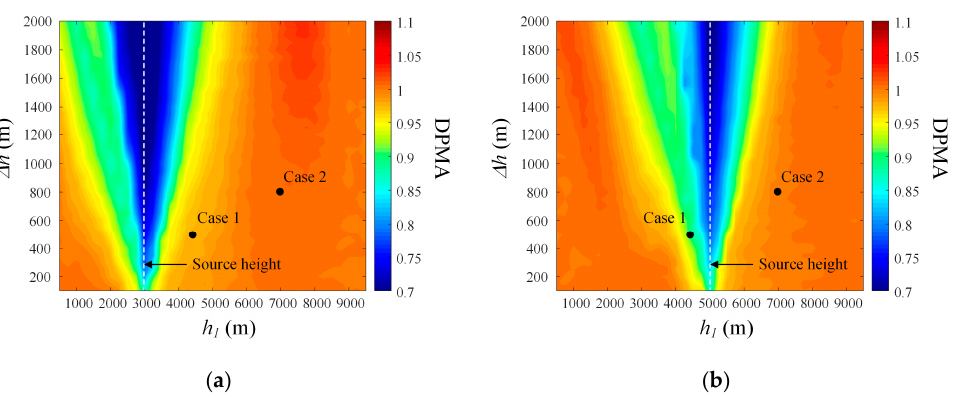
Figure 9. Detection performance metric in terms of the atmosphere (DPMA) map in accordance with the duct height and thickness: ( a ) h s = 3 km; ( b ) h s = 5 km.